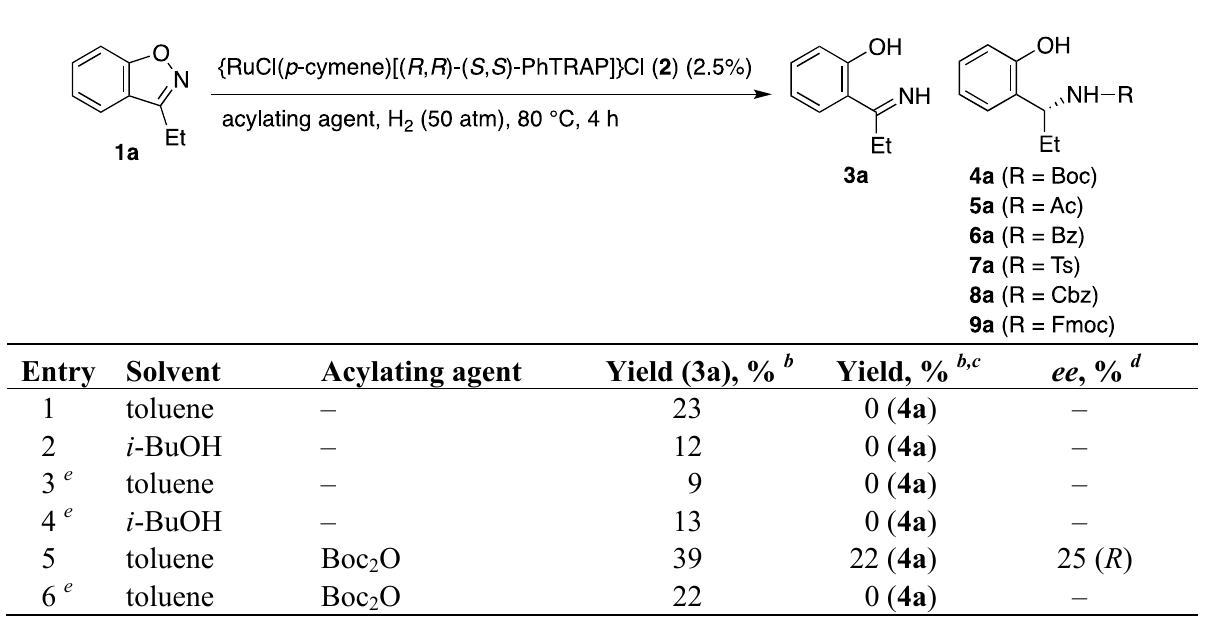
Table 1. Optimization of reaction conditions for the hydrogenation of 1a a